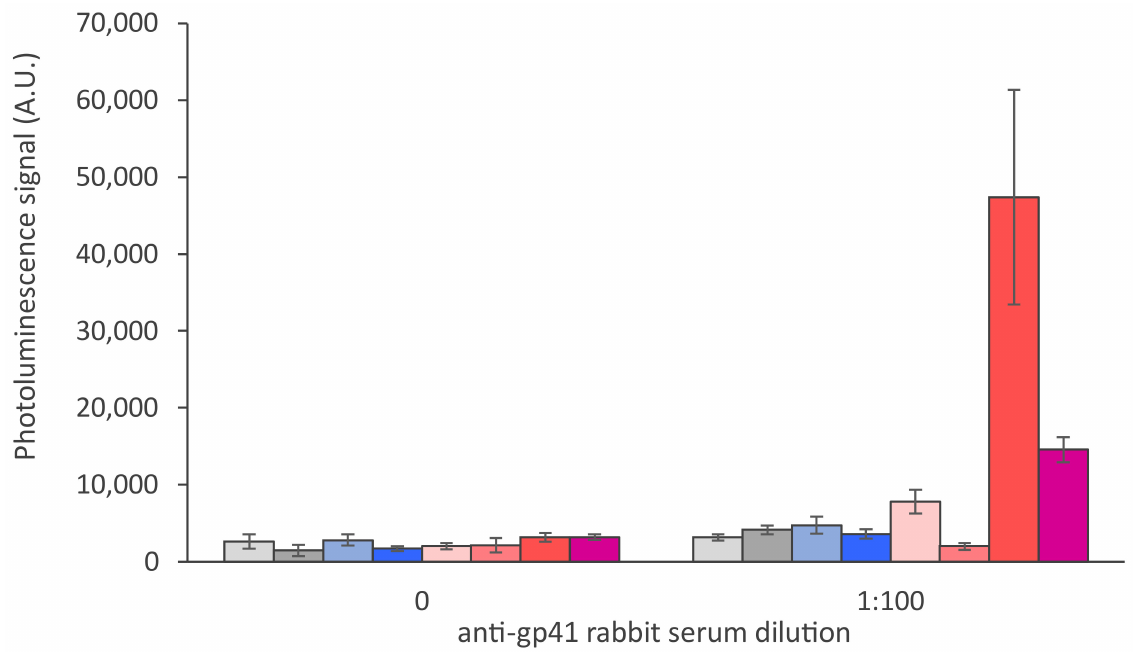
Figure 3. Nitrocellulose membrane comparison in the UCNP-LFA. Eight different nitrocellulose membranes with wicking rates of 100, 120, 125, 140, 150, 180, 200 and 220 s/4 cm (from left to right, respectively; details in Table 2) were compared in the UCNP-LFA with 1:100 dilution of anti-gp41 rabbit serum. The error bars represent the standard deviation among three replicate